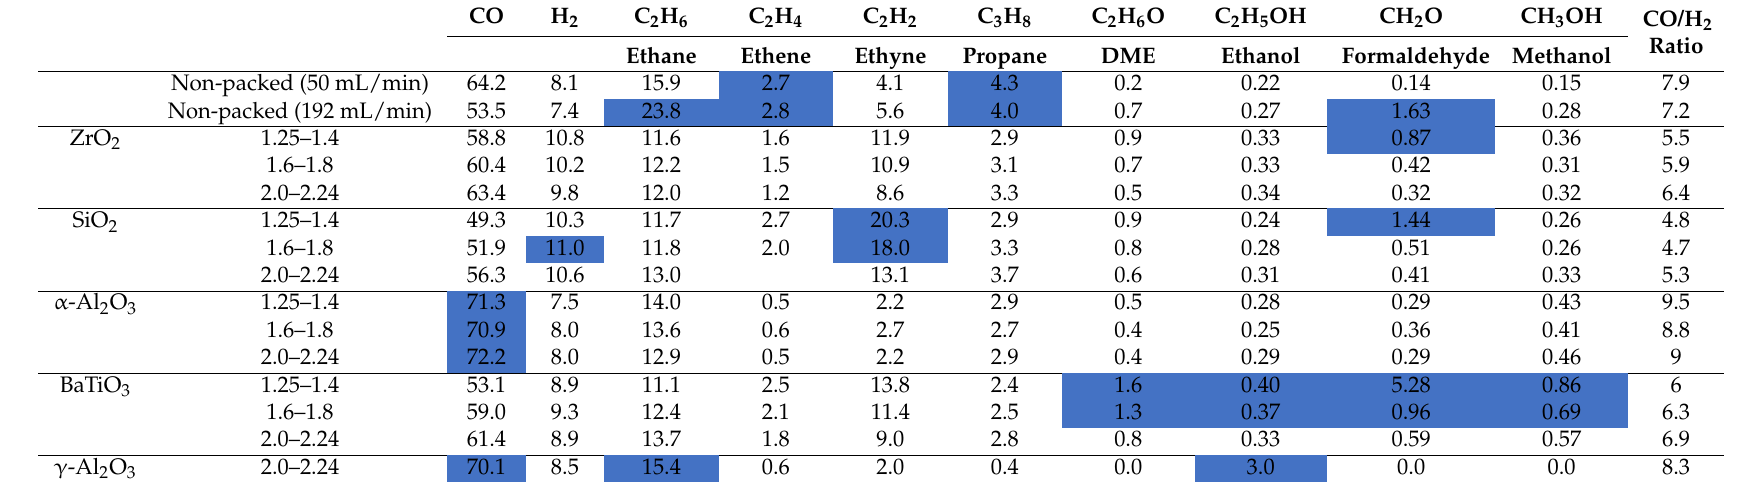
Table 4. Product fractions for different sphere sizes and materials (the highest fractions for each component are